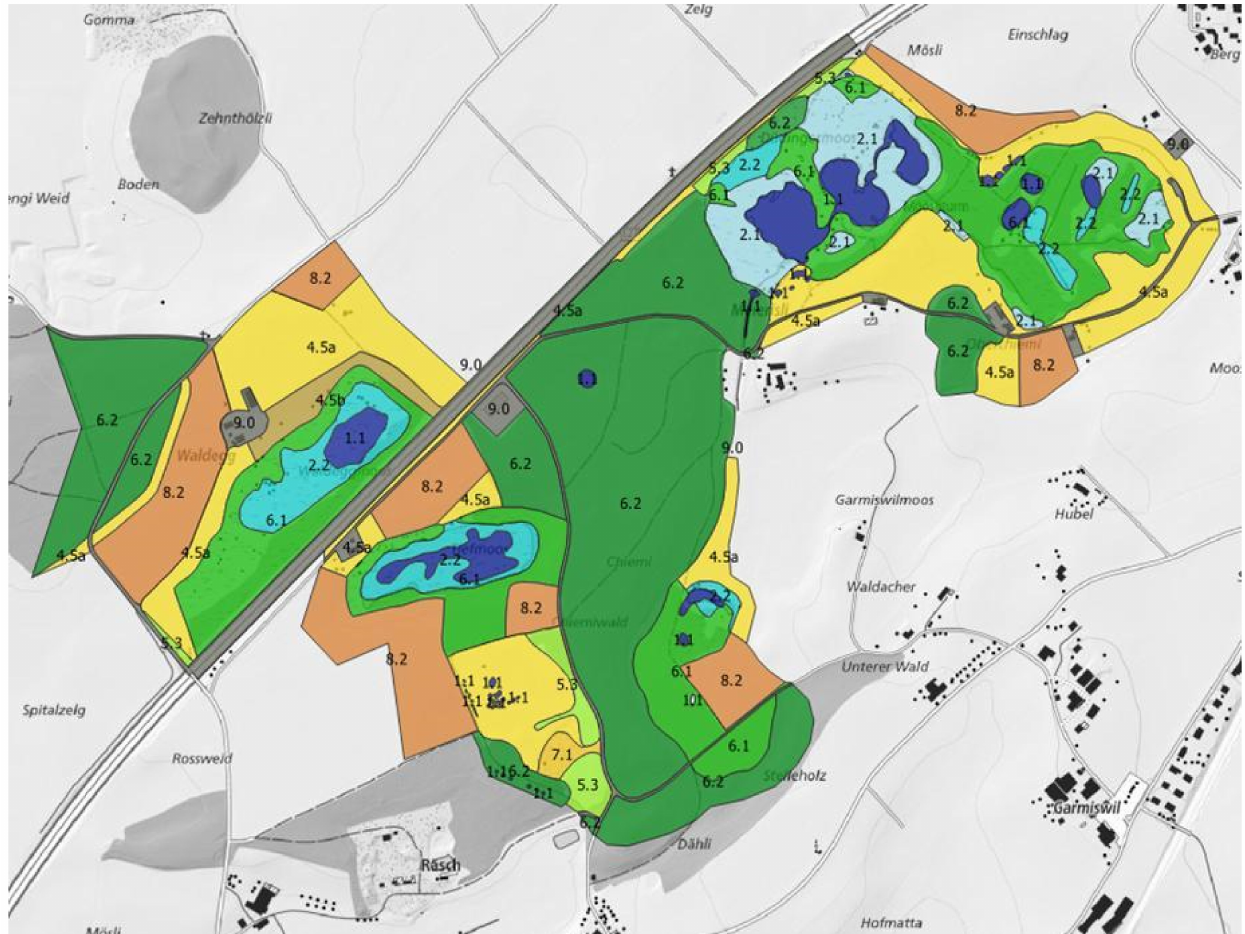
Figure 1. Example of a habitat map. It shows the protected amphibian breeding site of national importance “Düdingermoos” in western Switzerland. Blue colours indicate ponds (dark blue) and surrounding wetland vegetation (light blue). Green colours are forests (dark green) and shrubs (light green), yellow colours are meadows and pastures, and brown colours are arable lands. Grey is human infrastructure (e.g., roads). Numbers denote habitat types following [45]. The mapped area (in colour in this figure) is the total area of the protected site (cf. Table 1). Areas that are not coloured (different types of grey) represent the non-protected landscape surrounding the amphibian breeding sites; dark grey is used for forests. The site has a west–east extent of 1.65 km. ©